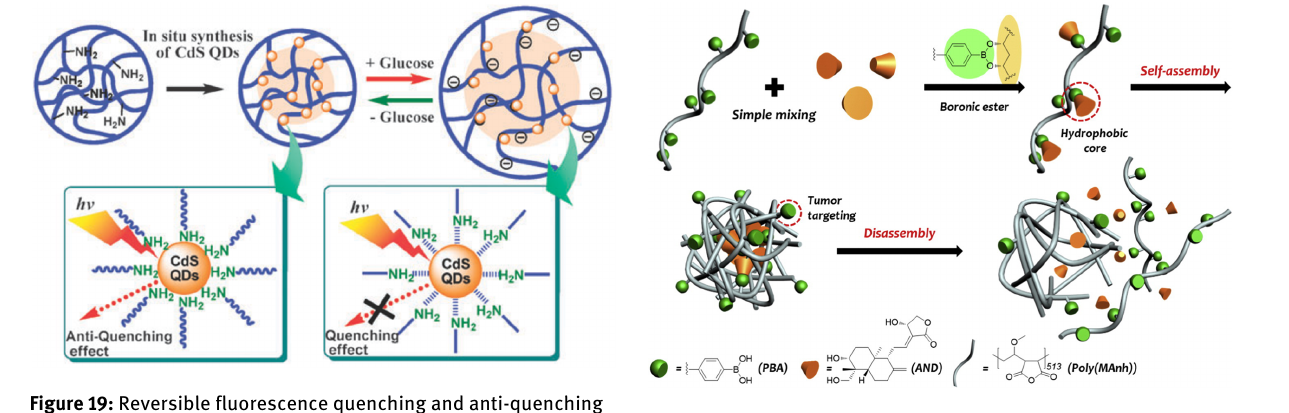
Figure 21: Schematic illustration for the formulation and destruction of pPBA-AND nanoconstruct. Reprinted with permission from